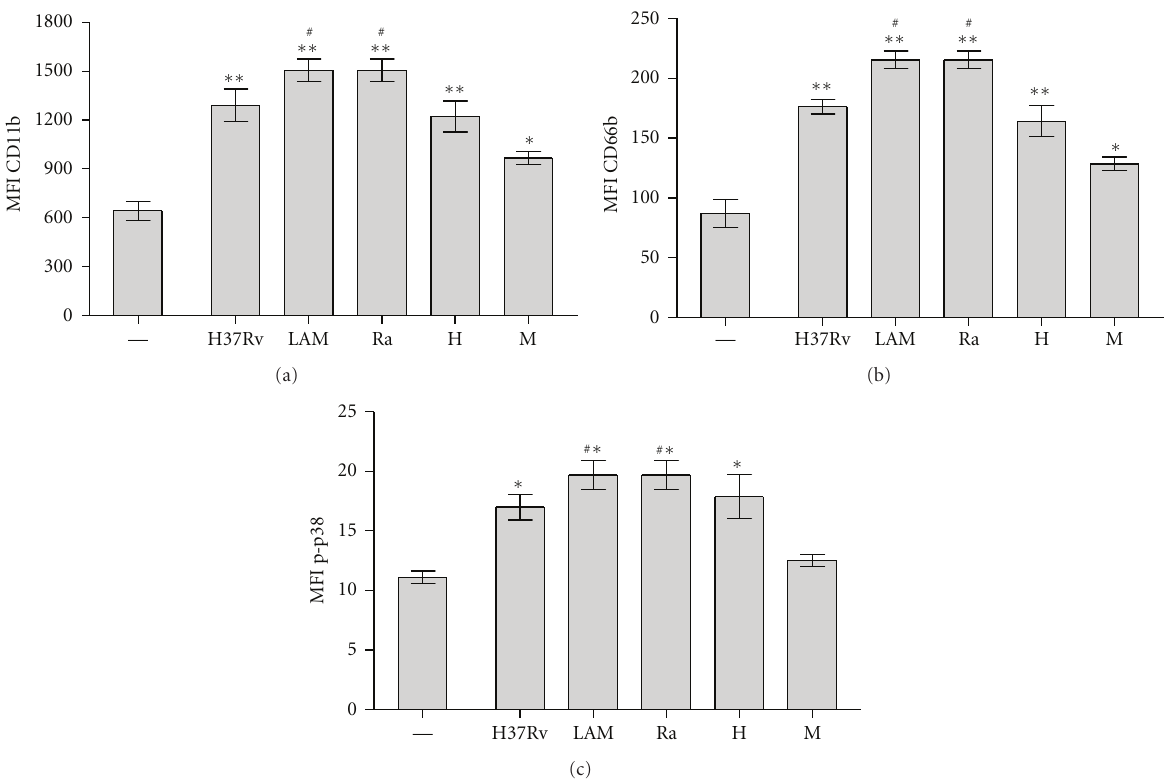
Figure 3: CD11b, CD66b, and p-p38 MAPK expression in PMN induced by Mtb strains. PMNs (3 × 10 6 /mL) were cultured in media alone (control, —) or stimulated with Mtb strains at 1 :2 Mtb :PMN ratio for 3 h. (a) and (b) Surface expression of activation markers was evaluated by flow cytometry and results are expressed as media ± SEM of MFI ( n = 10). Statistical di ff erences: CD11b and CD66b: control (—) versus H37Rv, LAM, Ra and H: ∗∗ P < 0 . 001; control versus M: ∗ P < 0 . 05; LAM and Ra versus other strains: # P < 0 . 01; (c) PMNs (3 × 10 6 /mL) were cultured in media alone (control, —) or stimulated with Mtb strains at 1 :2 Mtb :PMN ratio for 1h. Intracellular activated form of p38 (p-p38) was measured by flow cytometry. Results are expressed as media ± SEM ( n = 10). Statistical di ff erences: control versus H37Rv, LAM, Ra, and H: ∗ P < 0 . 001; LAM and Ra versus other strains: # P < 0 .